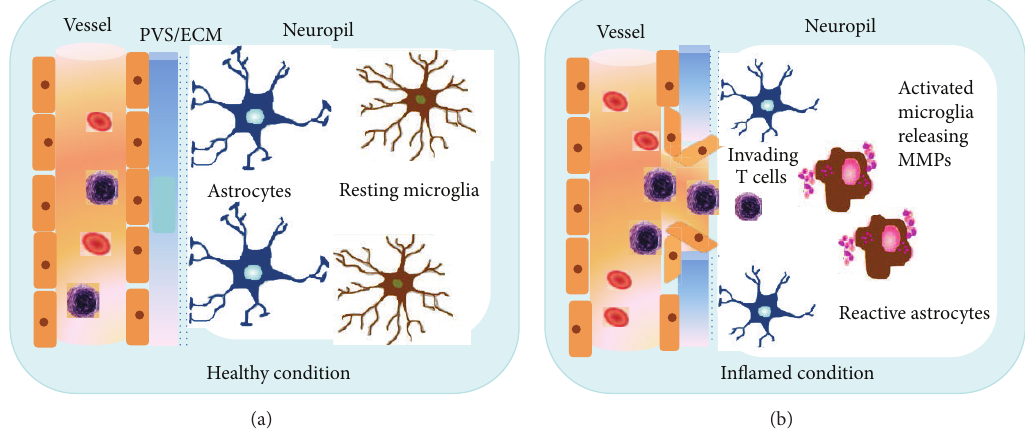
Figure 2: The blood brain barrier (BBB) in healthy and inflamed condition. (a) Vessel, endothelium, extracellular matrix (ECM), and glia limitans are intact. Microglia cells are in a resting state. (b) In the inflammed CNS breakdown of the BBB takes places. The glia limitans is opened, and astrocytic endfeet are drawn away. Reactive microglia secrete MMPs facilitating the opening of the BBB. Invading T cells migrate from the vessel via the perivascular space (PVS) into the